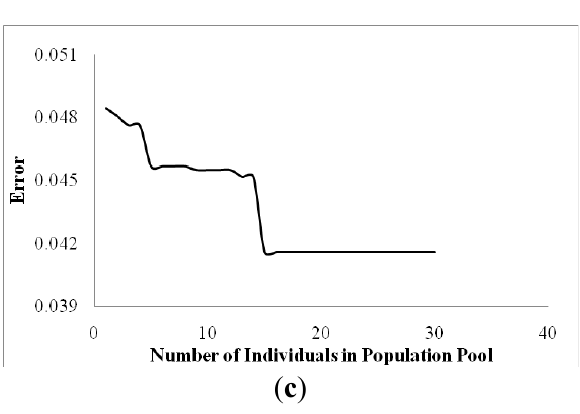
Figure 6. ( a ) Error vs. Number of Generations. ( b ) Error vs. Training Pool Size. ( c ) Error Accounted vs. Number of Individuals in the Population Pool.